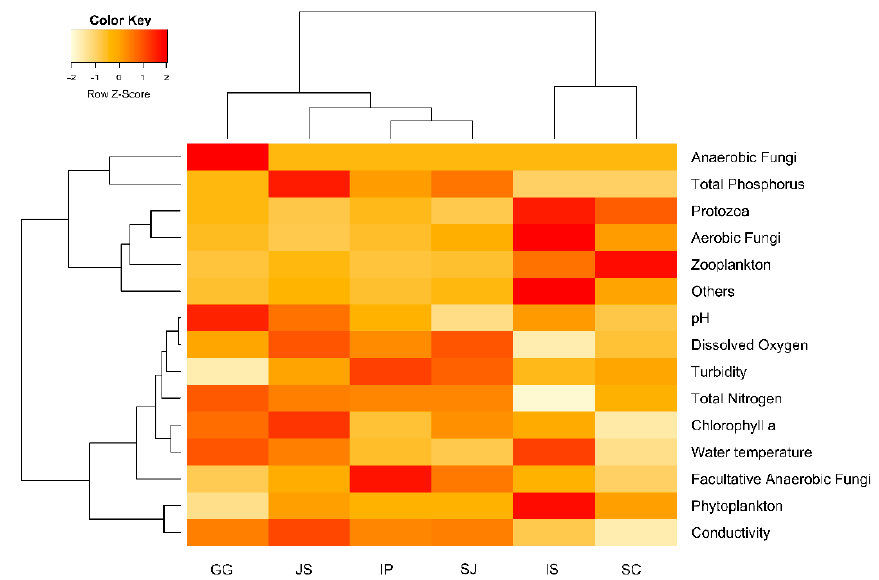
Figure 4. The two-way clustering analysis shows the relationship between environmental parame- ters with different food sources in the diet profile of river and weir chironomids. The vertical axis was the environmental conditions and major groups of food sources. The horizontal axis indicates the study habitats. Food sources—Phytoplankton was included with Chlorophyta, Diatomea, Dinoflagellata, Ochrophyta, Phragmoplastophyta, Cryptophyta, and Haptophyta; Aerobic Fungi (Ascomycota, Basidiomycota, Chytridiomycota, and Cryptomycota), Anaerobic Fungi (Neocallimastigomycota), Facultative Anaerobic Fungi (Peronosporomycetes); Amoebozoa, Cercozoa, Ciliophora, Euglenozoa, Heterolobosea, and Protalveolata were grouped to Protozoa, Annelida, Arthropoda, Cnidaria, Marine Stramenophiles, Mollusca, Nematozoa, Nucleariidae/Fonticula, and Vertebrata were grouped as others and Rotifera included as Zooplankton.